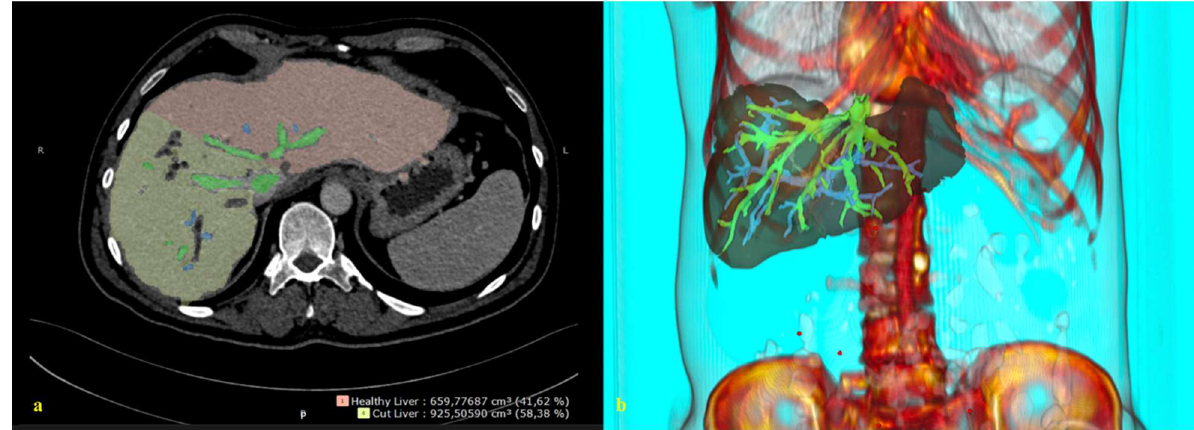
Figure 2. A 3D reconstruction of the radiological image. ( a ) A 2D abdominal computerized tomog- raphy scan, axial. ( b ) A 3D reconstruction and image integration of the portal and hepatic venous system of the liver.